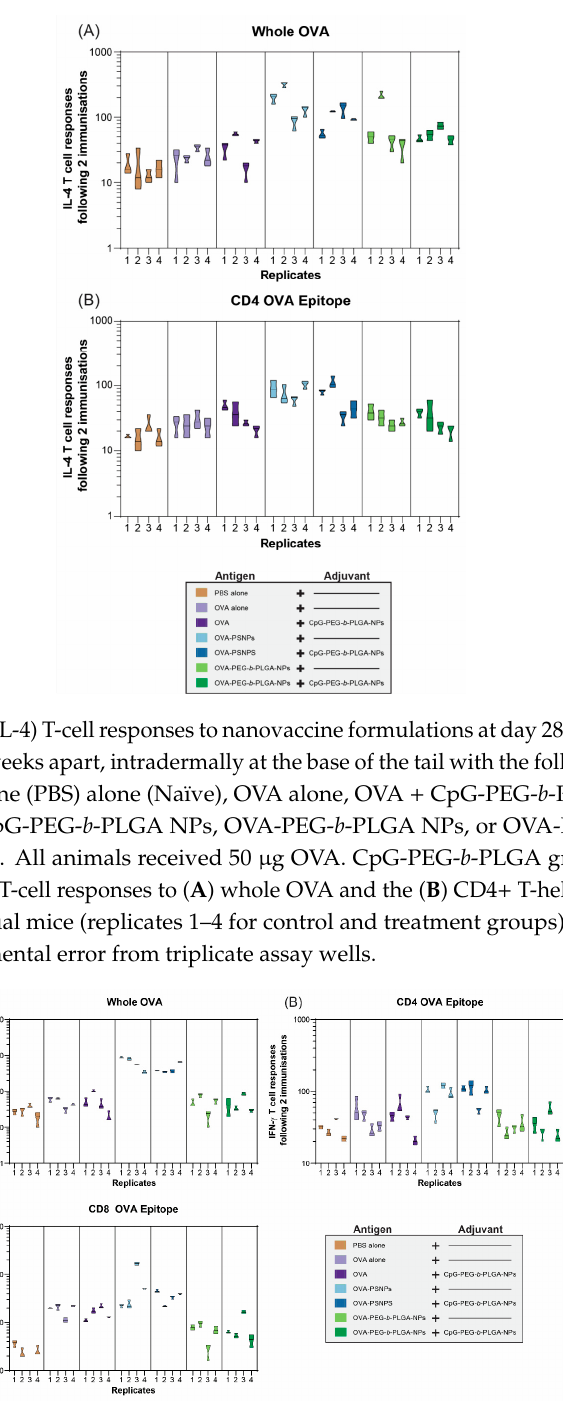
Figure 5. Correlations between cytokine levels and antibody end titers at day 28. C57BL/6 mice were immunized twice, two weeks apart, intradermally at the base of the tail with the following formulations; PBS alone (Naïve), OVA alone, OVA + CpG-PEG- b -PLGA NPs, OVA-PS NPs, OVA-PS NPs + CpG-PEG- b -PLGA NPs, OVA-PEG- b -PLGA NPs, or OVA-PEG- b -PLGA NPs + CpG-PEG- b - PLGA NPs. All animals received 50 µg OVA. CpG-PEG- b -PLGA NP groups received 5 µg CpG. Graphs show linear regression correlations between average antibody end titer (log) and the average